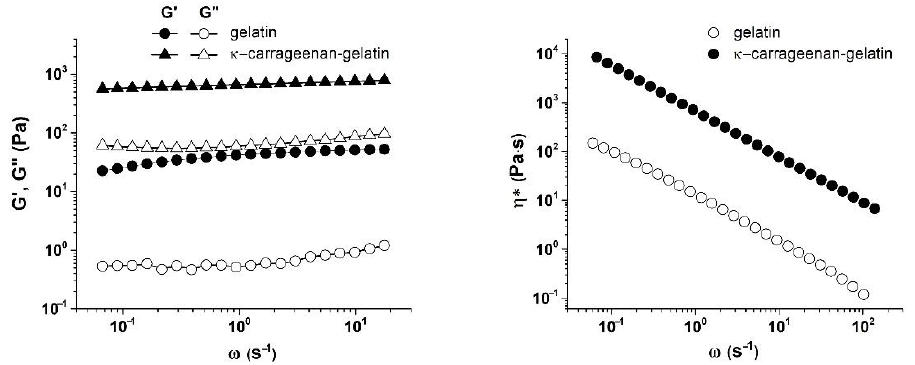
Figure 9. Frequency dependences of A: elastic (G ’ ) and loss (G ’’ ) moduli and B: complex viscosity (η*) of gelatin and κ -carrageenan-gelatin gels at T = 14 °C and γ =